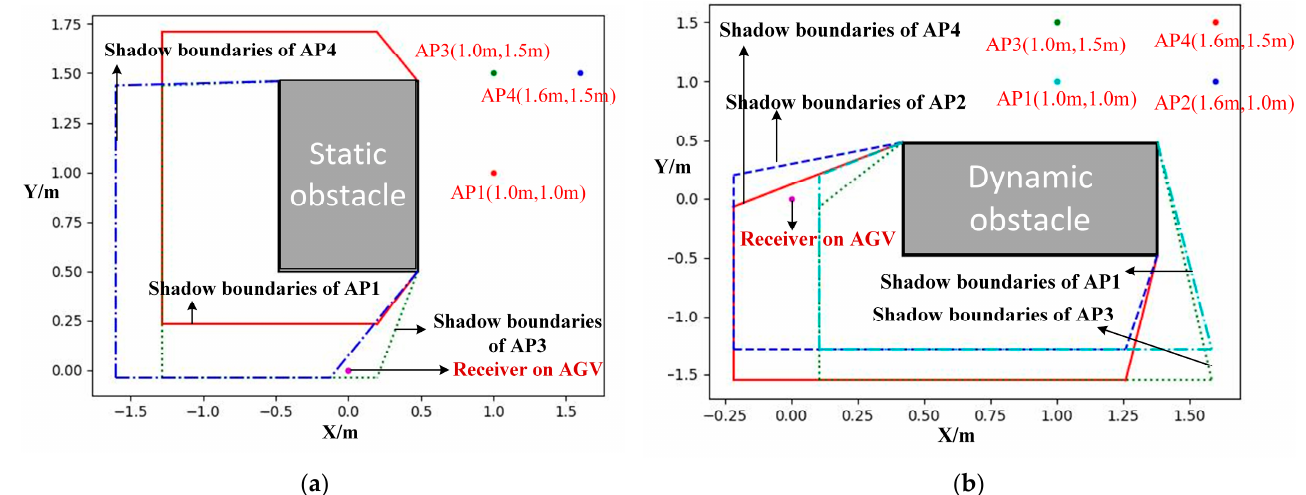
Figure 10. Shadows of APs under the influence of obstacle: ( a ) static obstacle; ( b ) dynamic obstacle.